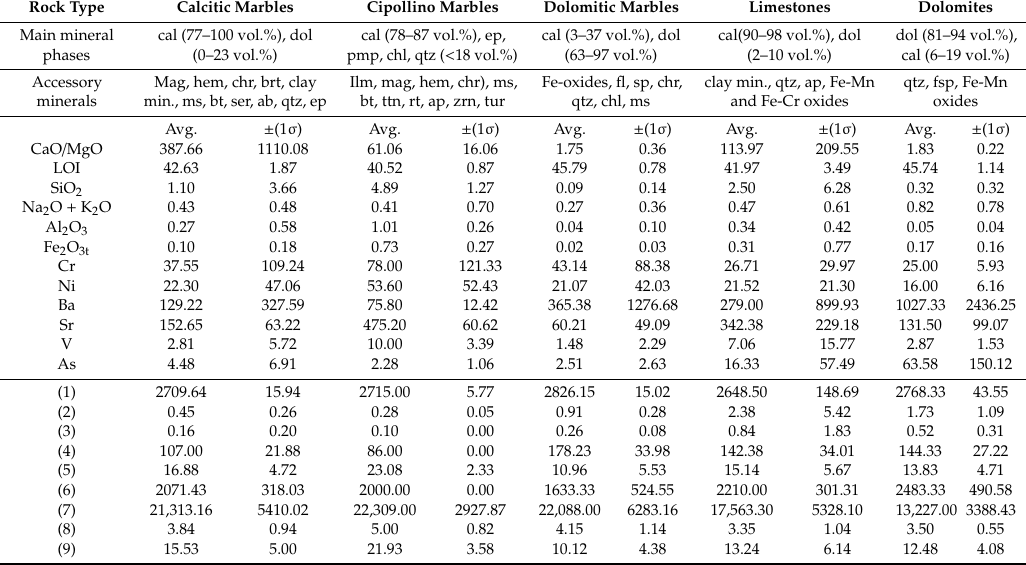
Table 2. Simplified table including average CaO / MgO ratios, mineralogical, geochemical and physico-mechanical properties for every type of rock along with their standard deviation (from Tables S1 and S2) of the 73 selected Greek carbonate ornamental stone